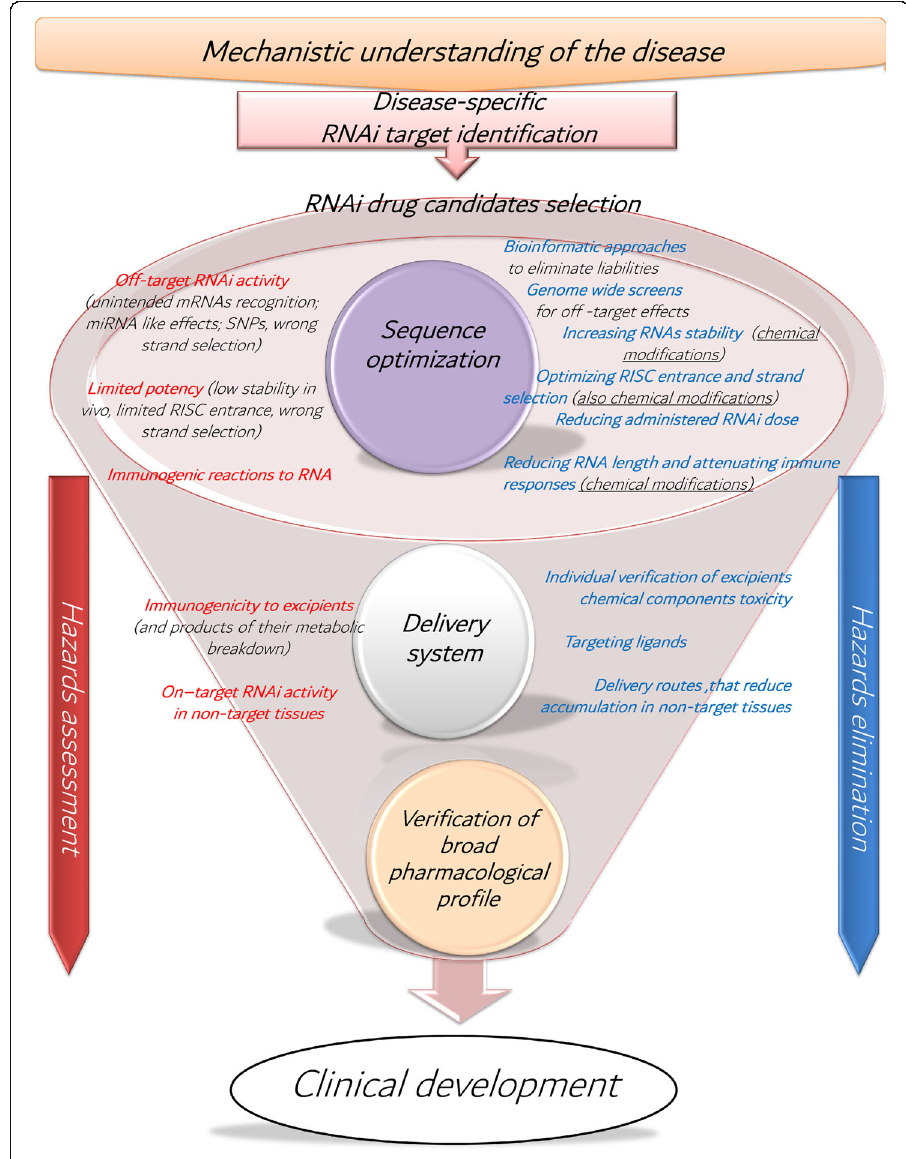
Fig. 1. Schematic representation of the RNAi drug discovery and development process. Full mechanistic understanding of the disease allows selection of highly disease specific therapy targets, and thus early elimination of off-targets. In the first phase, candidate sequence design and optimization allows early hazard identification and elimination, whereas chemical modifications can be applied to design out potential hazards and limitations. Furthermore, in later phases potential liabilities regarding delivery system choice should be assessed. Finally, broad pharmacological profiles of the lead drug candidates should be obtained, before drug candidates undergo further clinical